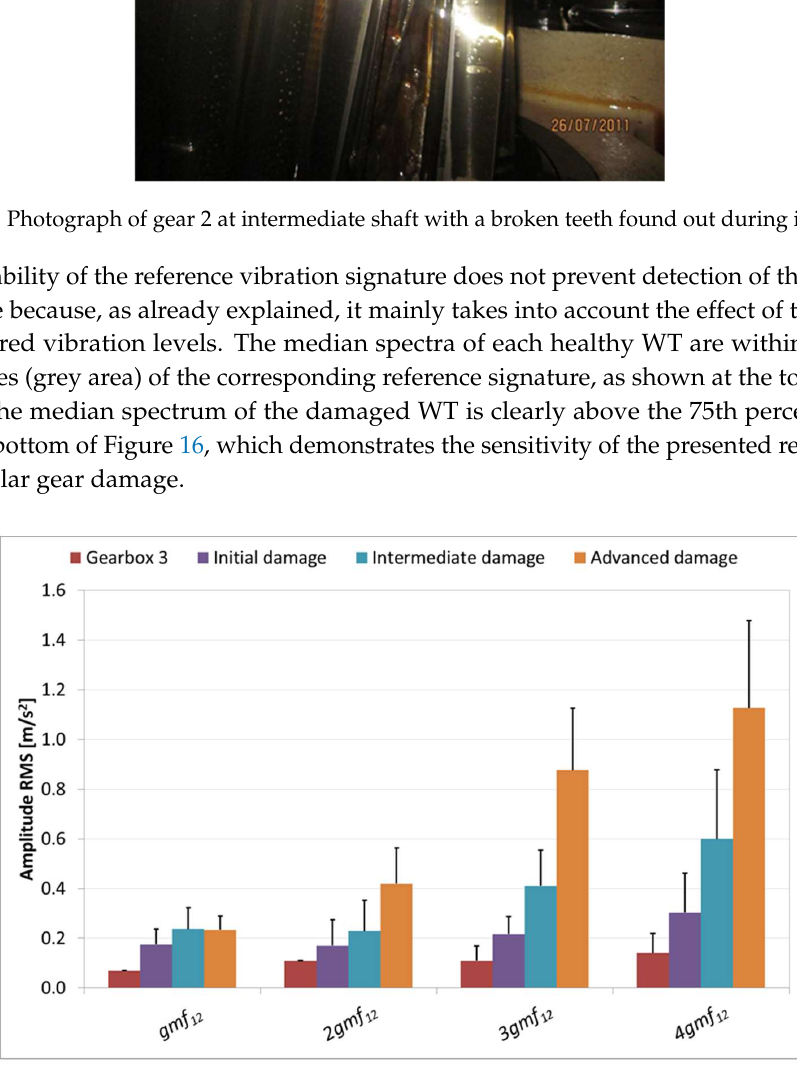
Figure 14. Comparison between the reference mean vibration acceleration RMS values of the gear mesh frequency and its harmonics (measurement gearbox 3) and the corresponding mean values in a particular wind turbine with progressive levels of gearbox damage.